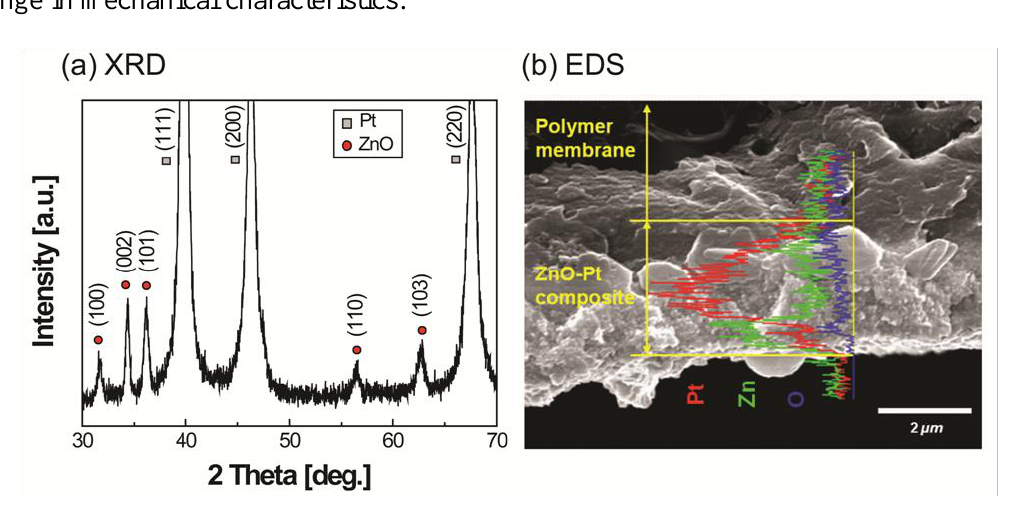
Figure 3. IPMZC characterization results showing ZnO layer on IPMC substrate and change in mechanical